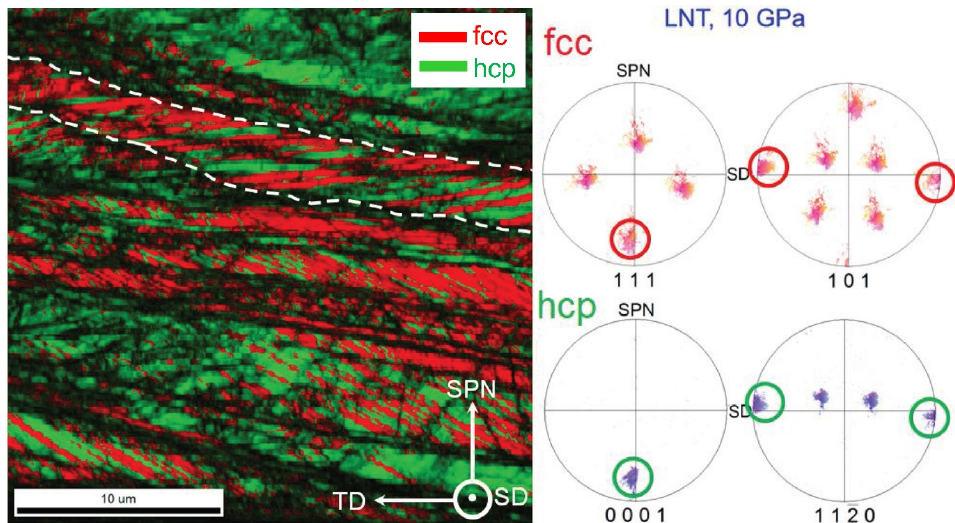
Figure 1. Distribution of fcc and hcp phase in a sample HPT-deformed at LNT and 10 GPa demonstrated by EBSD. The area shown represents a weakly deformed region. The pole figures of the encircled area demonstrate the orientation relationship of the fcc/hcp lamellae.